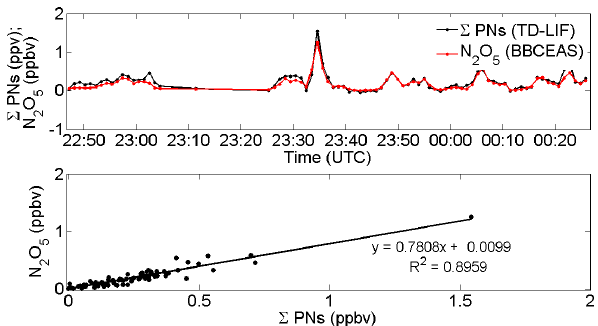
Figure 9. Upper panel: time series of in-flight measurements of NO 2 , on board the research 2 Fig. 9. Upper panel: time series of in-flight measurements of NO 2 , aircraft BAe 146-301, detected by a chemiluminescence system and by the TD-LIF. 3 on board the research aircraft BAe 146-301, detected by a chemilu- Lower panel: scatter plot of NO 2 measured by a chemiluminescence system and by the TD-4 minescence system and by the TD-LIF. Lower panel: scatter plot of LIF reported in the upper plot of this figure. 5 NO 2 measured by a chemiluminescence system and by the TD-LIF reported in the upper plot of this figure.